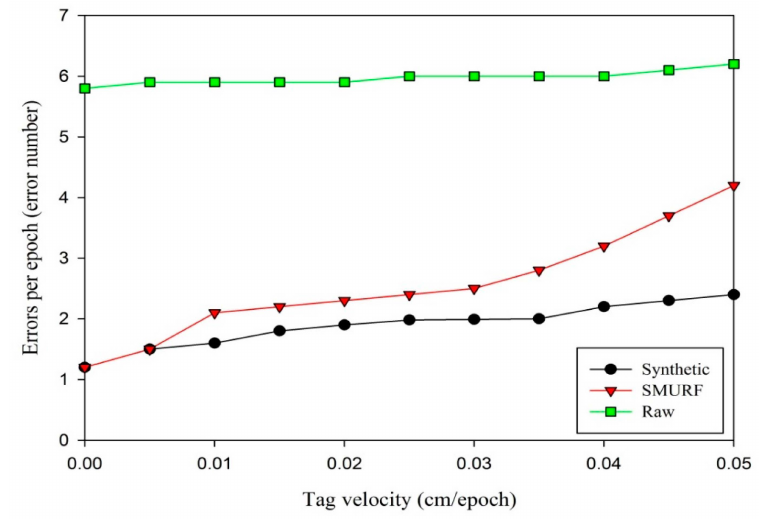
Figure 7. Average errors per epoch as tag velocity